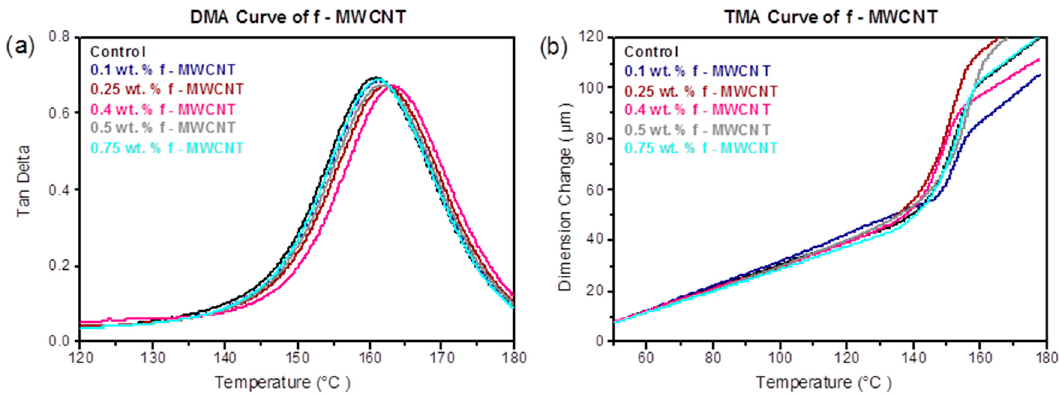
Figure 5. Damping behaviour ( a ) tan δ of f-MWCNT; ( b ) TMA curve of f-MWCNT. Table 3. Glass transition temperature T g and CTE of the f-MWCNT series relative to the neat epoxy. Loading of MWCNT (wt %) T g by DMA (°C)